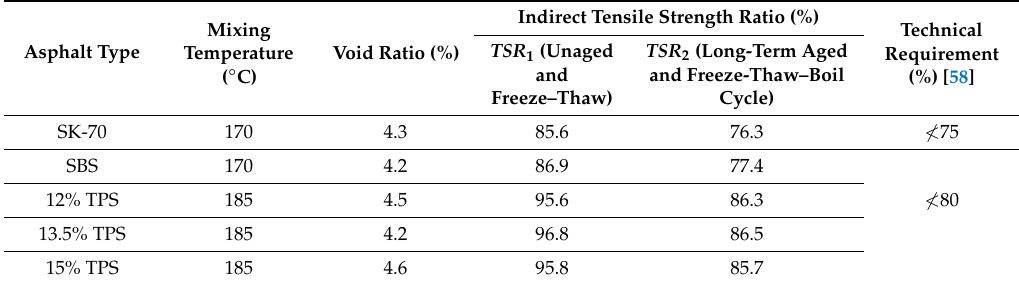
Table 7. Results of C á ntabro test under